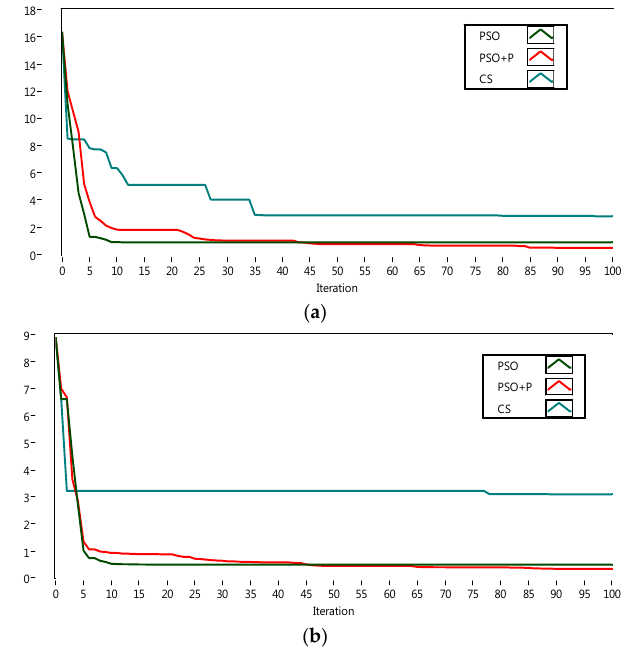
Figure 5. Optimization algorithms. ( a ) Charge mode algorithm performance, and ( b ) discharge mode algorithm performance.